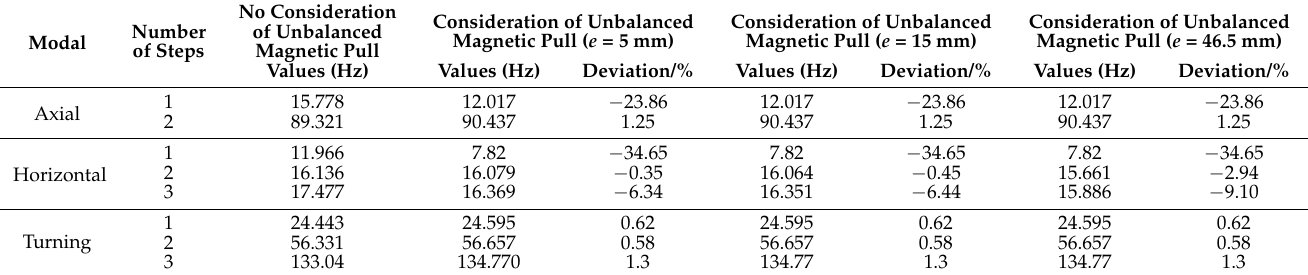
Table 3. Effect of unbalanced magnetic pull on the dynamic characteristics of the rotor